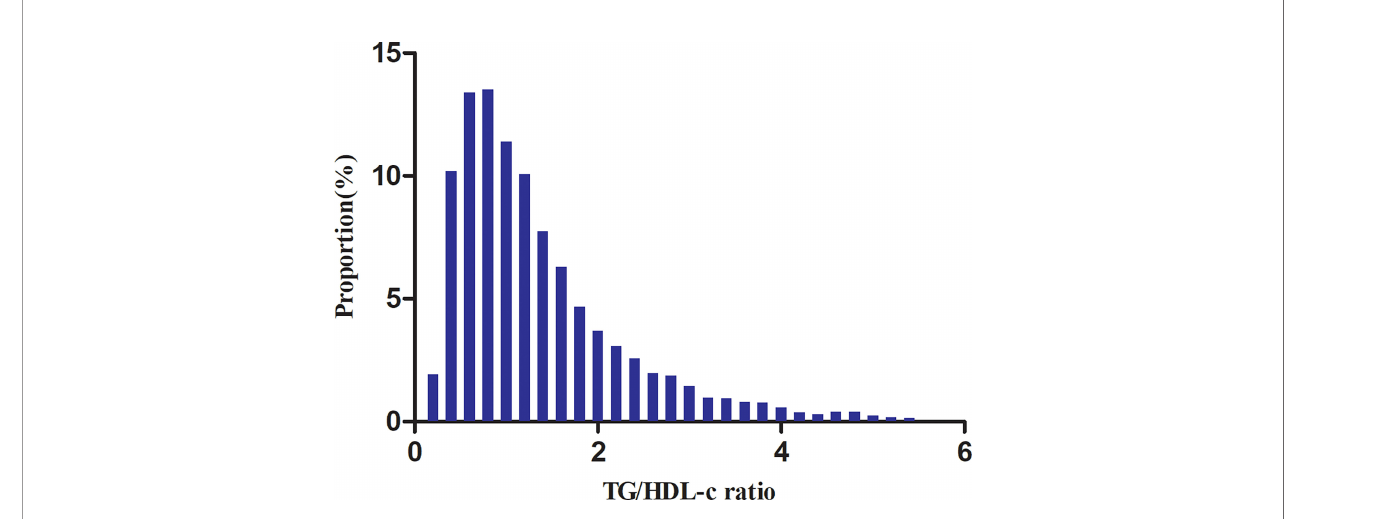
FIGURE 2 | Distribution of the TG/HDL-c ratio. It presents a skewed distribution while being in the range from 0.039 to 5.453, with a median of